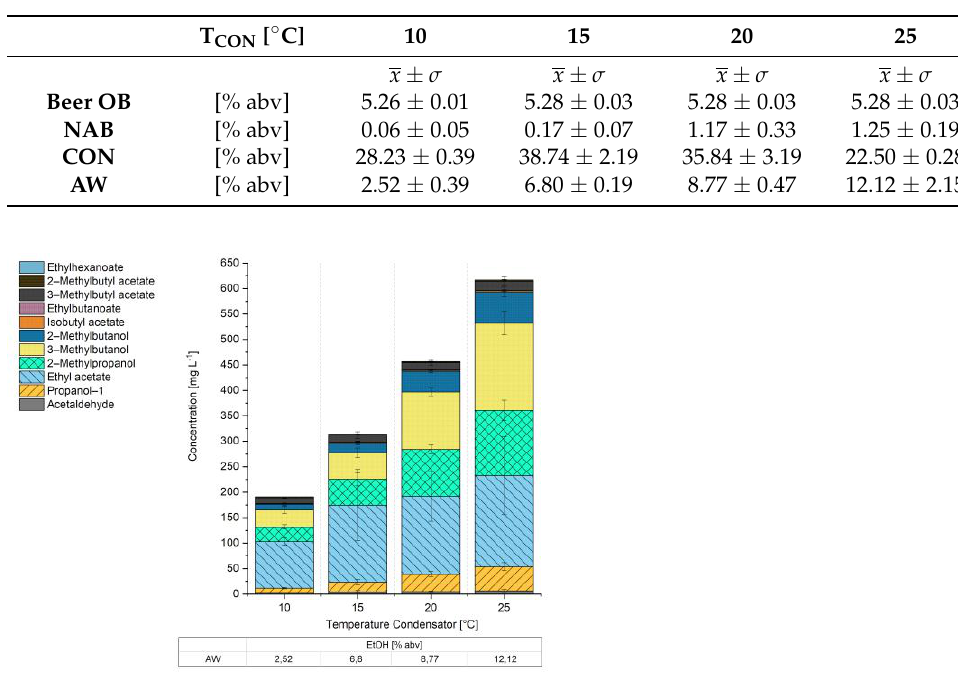
Figure 2. Individual and overall concentrations of the fermentation by-products present in the aromawater (AW) as a function of the condenser temperature. In the table at the bottom of the figure the corresponding ethanol (EtOH) concentration values of the AW are reported.